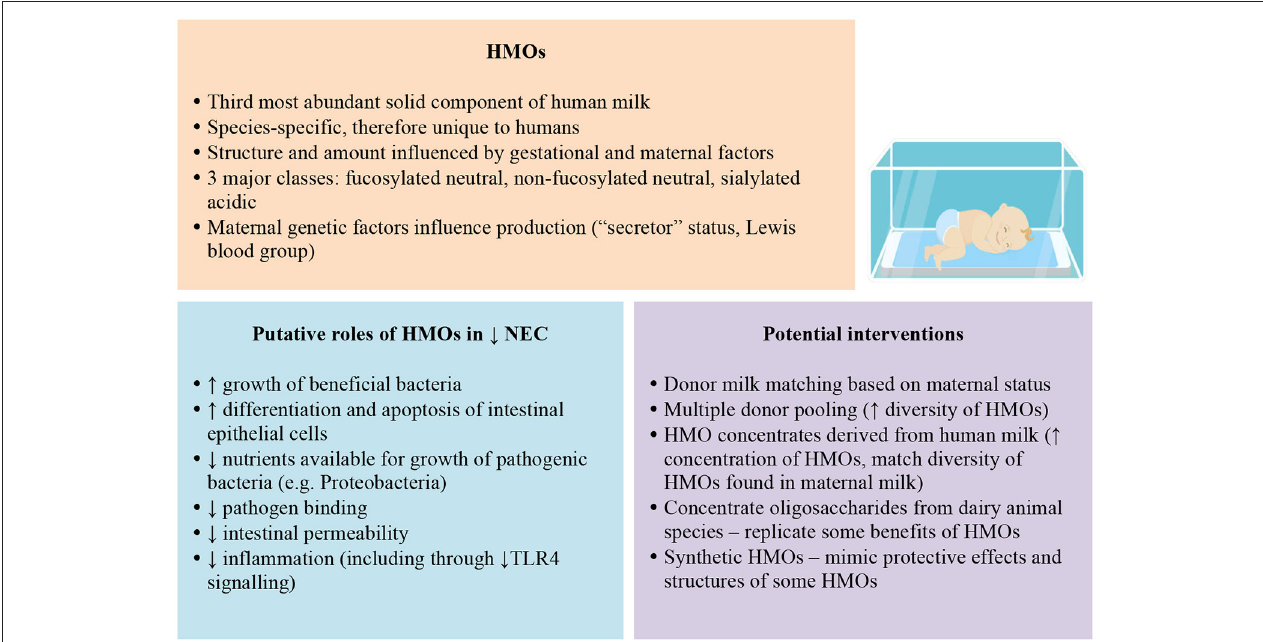
FIGURE 1 | Potential HMO mechanisms and interventions to prevent NEC in preterm infants.